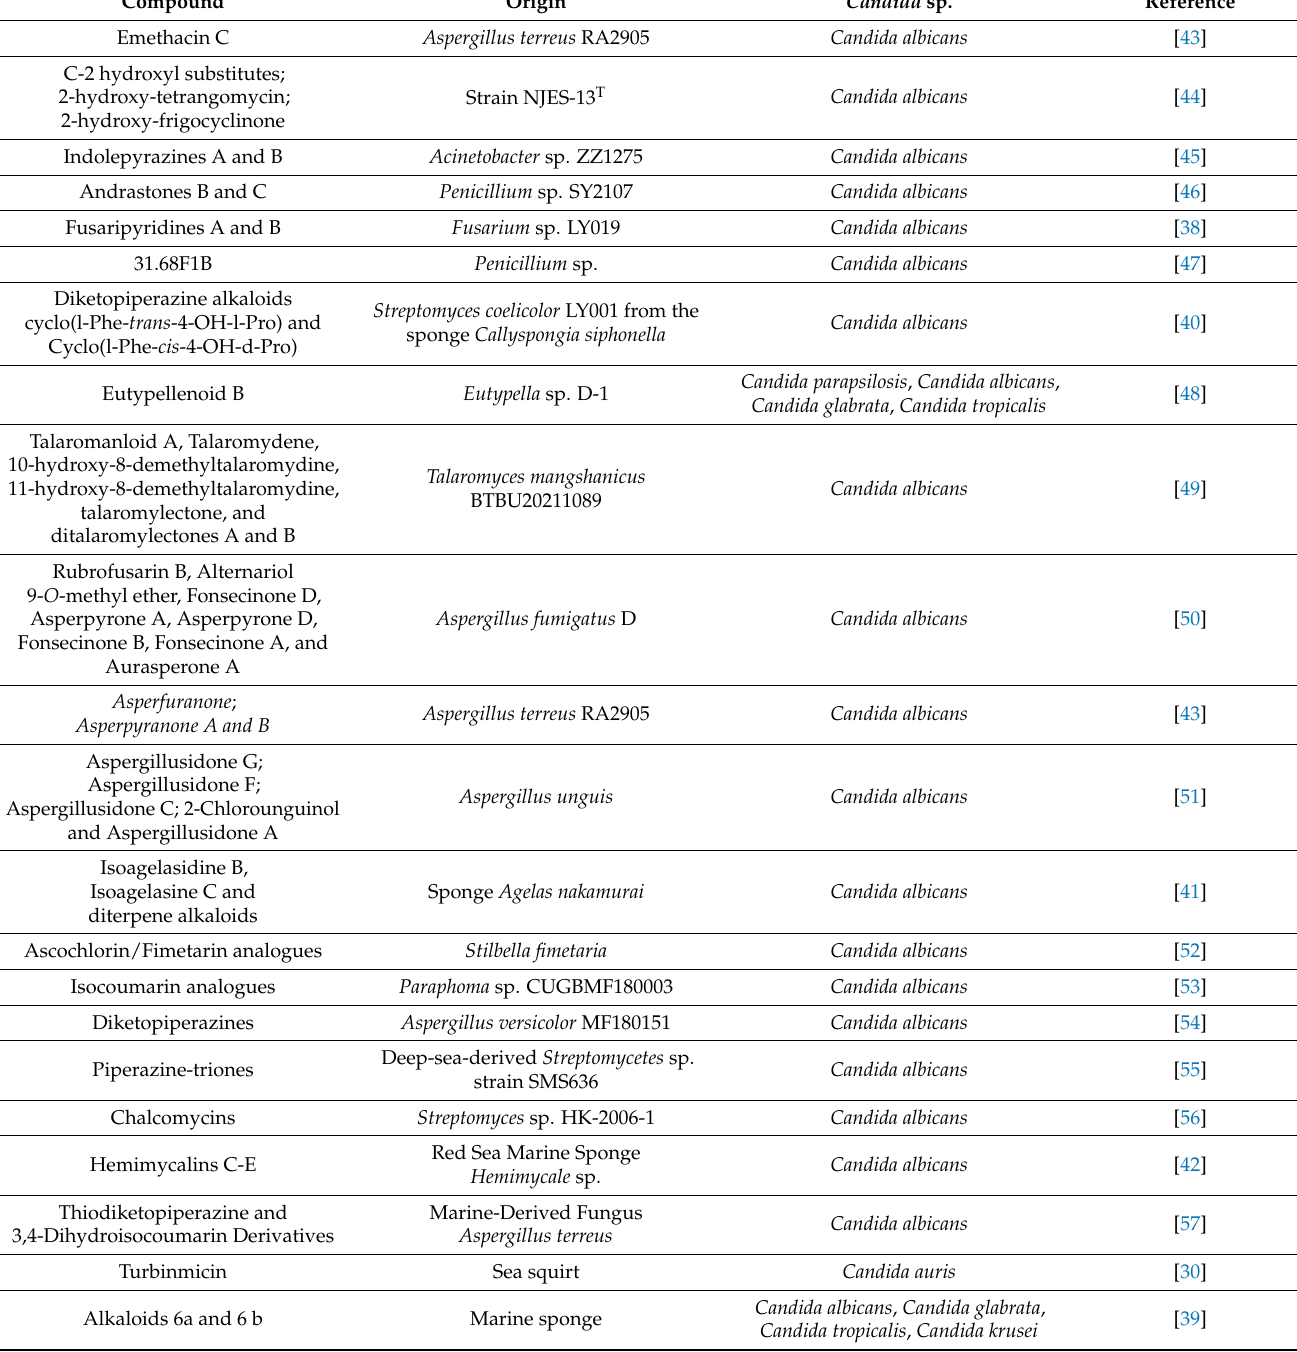
Table 2. Antifungal activity of marine alkaloids and